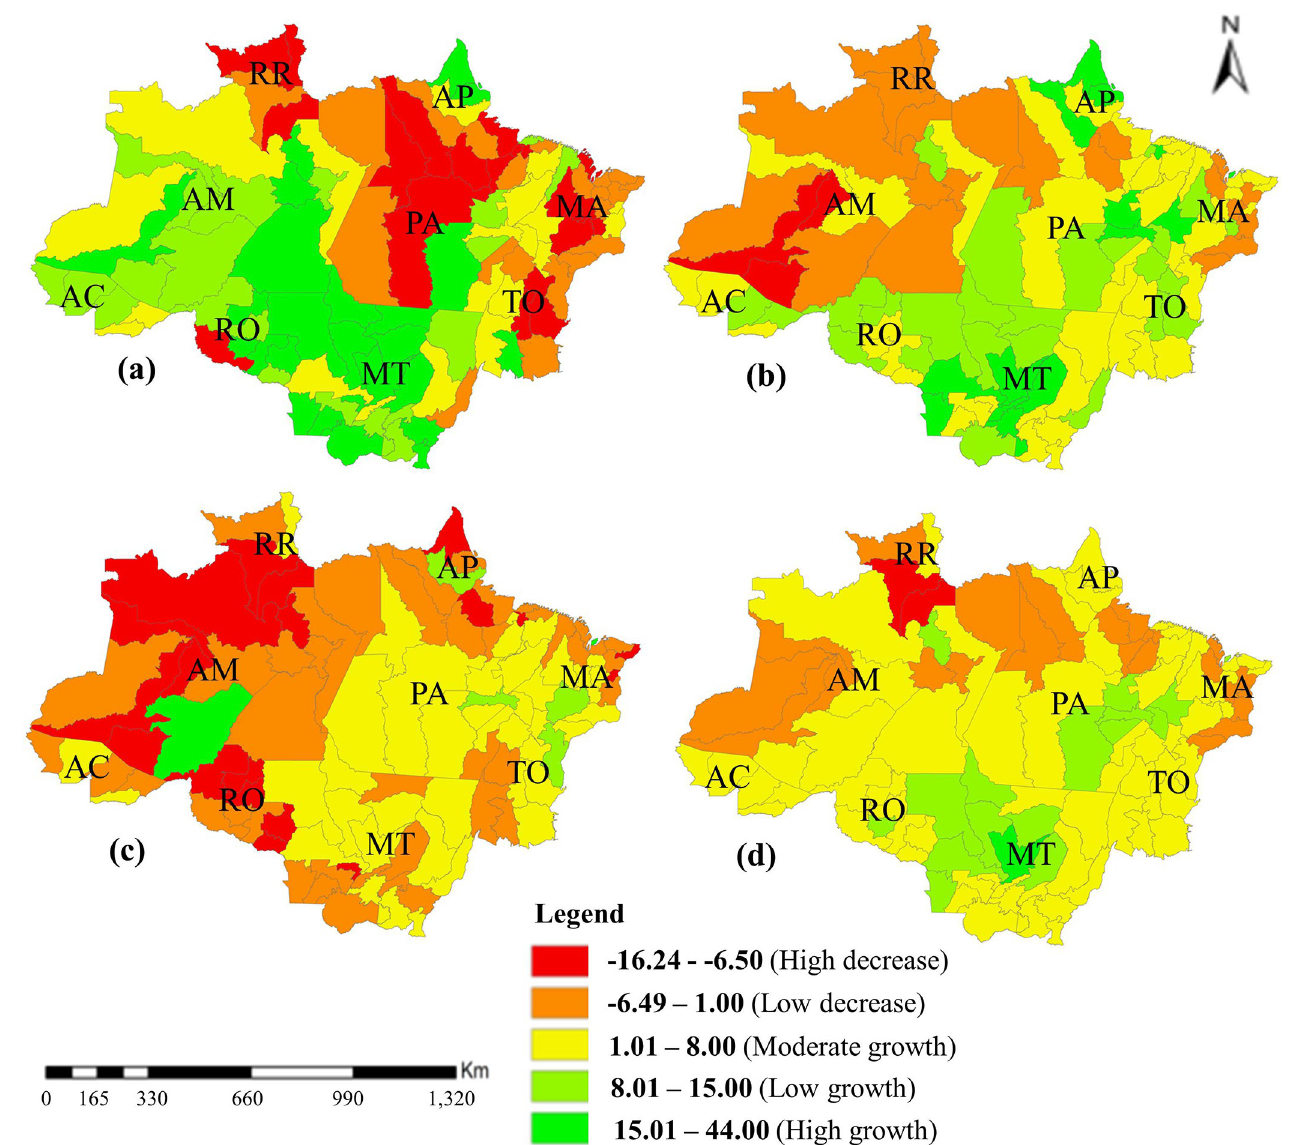
Fig 2. Geometric growth rate of sheep herd in Legal Amazon (a.1990-1999, b.2000-2009, c.2010-2020, d.1990-2020). RO, Rondo ˆ nia; AC, Acre; AM, Amazonas; RR, Roraima; PA, Para´; AP, Amapa´; TO, Tocantins; MA, Maranh ã o; MT, Mato Grosso.